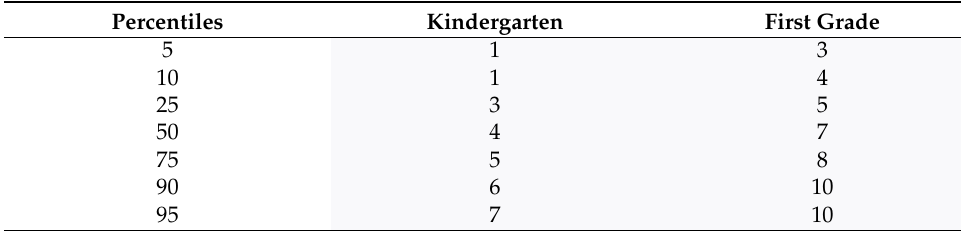
Table A4. Concepts of